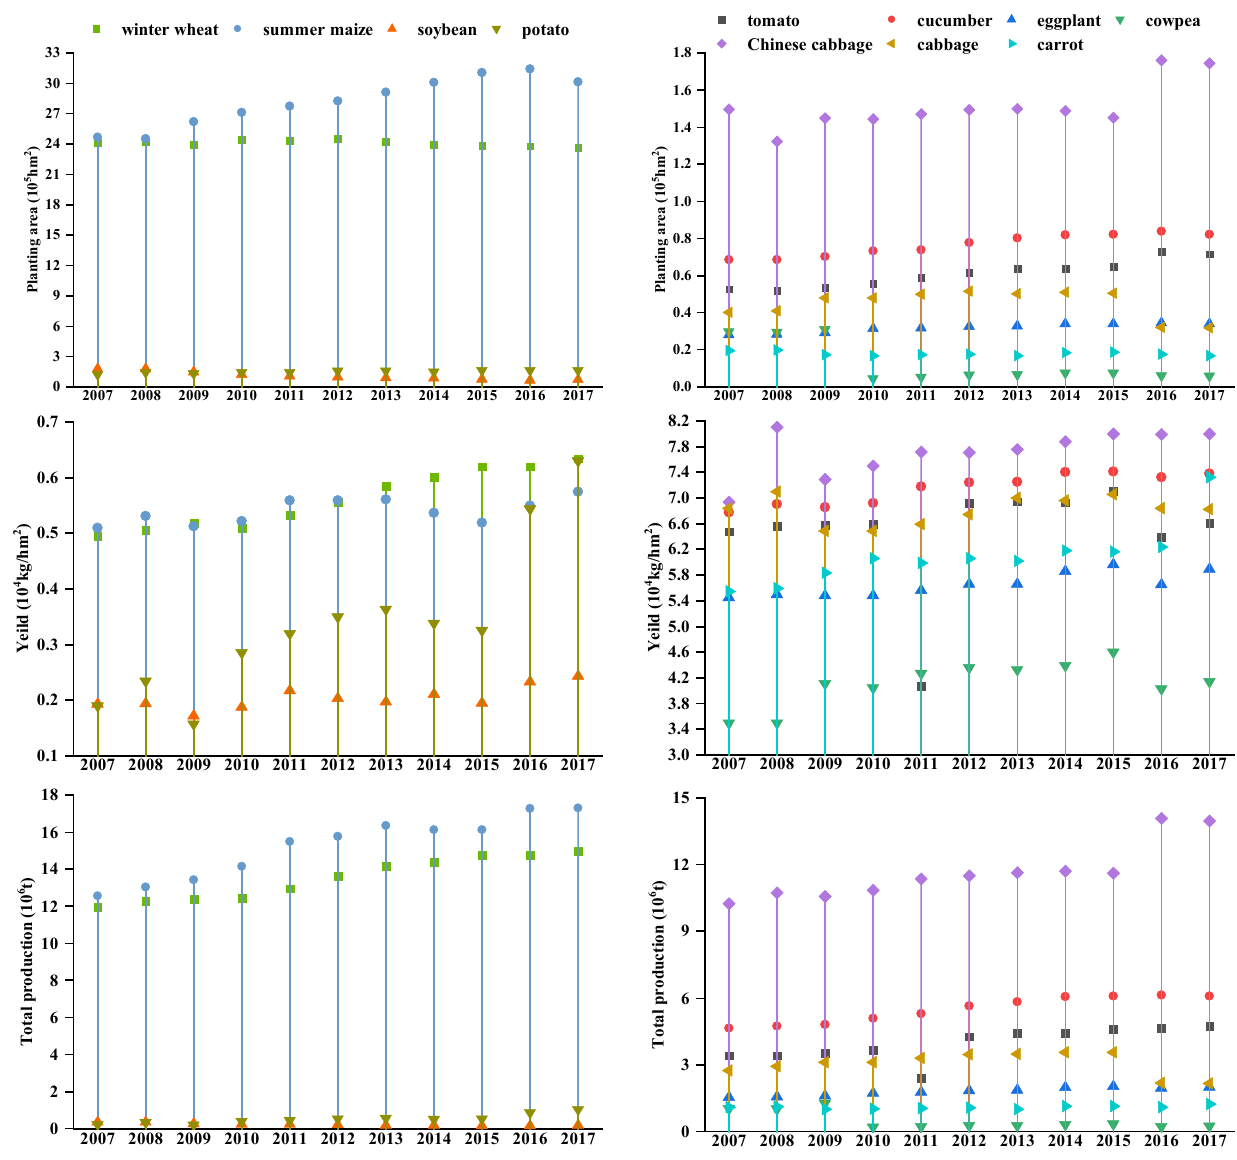
Figure 1. Changes in planting areas, yields and total production of grain crops ( left ) and vegetable crops ( right ) in Hebei Province from 2007 to 2017.